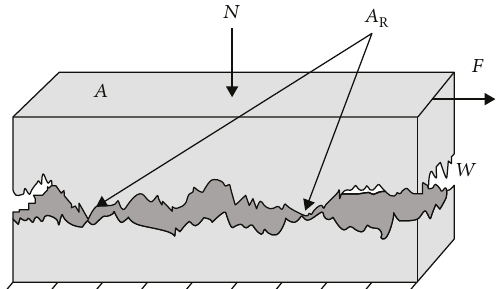
Figure 12: Conceptual model for a fault, modi fi ed after [81]. The fault is regarded as a fl uid- fi lled volume of area A and typical width W , its surfaces — with fractal distributions of irregularities — being in contact at asperities of area A ≪ A . N and F are the normal and shear forces acting across the A R fault, associated with the normal and shear stresses σ model simpli fi es the features depicted in Figure 4 for calculation purposes.